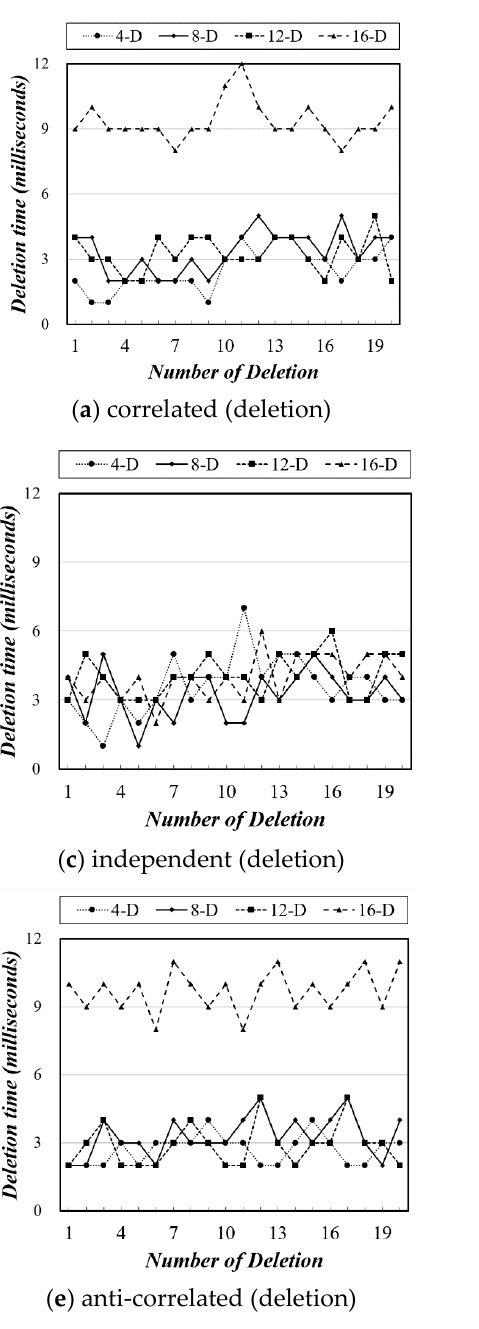
Figure 7. Results of HashGrid maintenance performance on dynamic dataset.